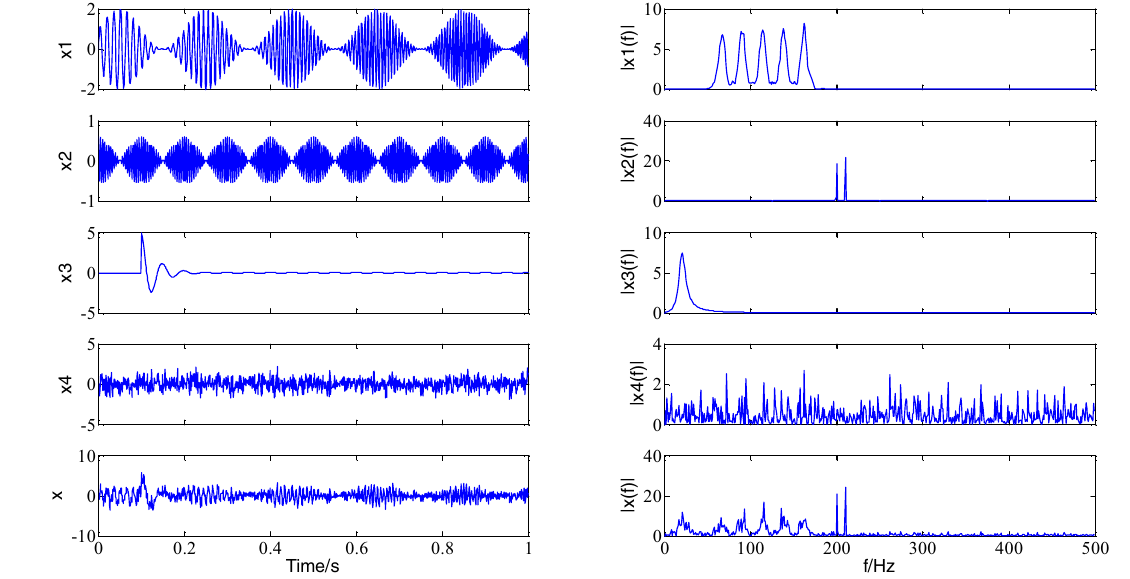
Figure 2. The time-domain and frequency-domain diagrams of every component.